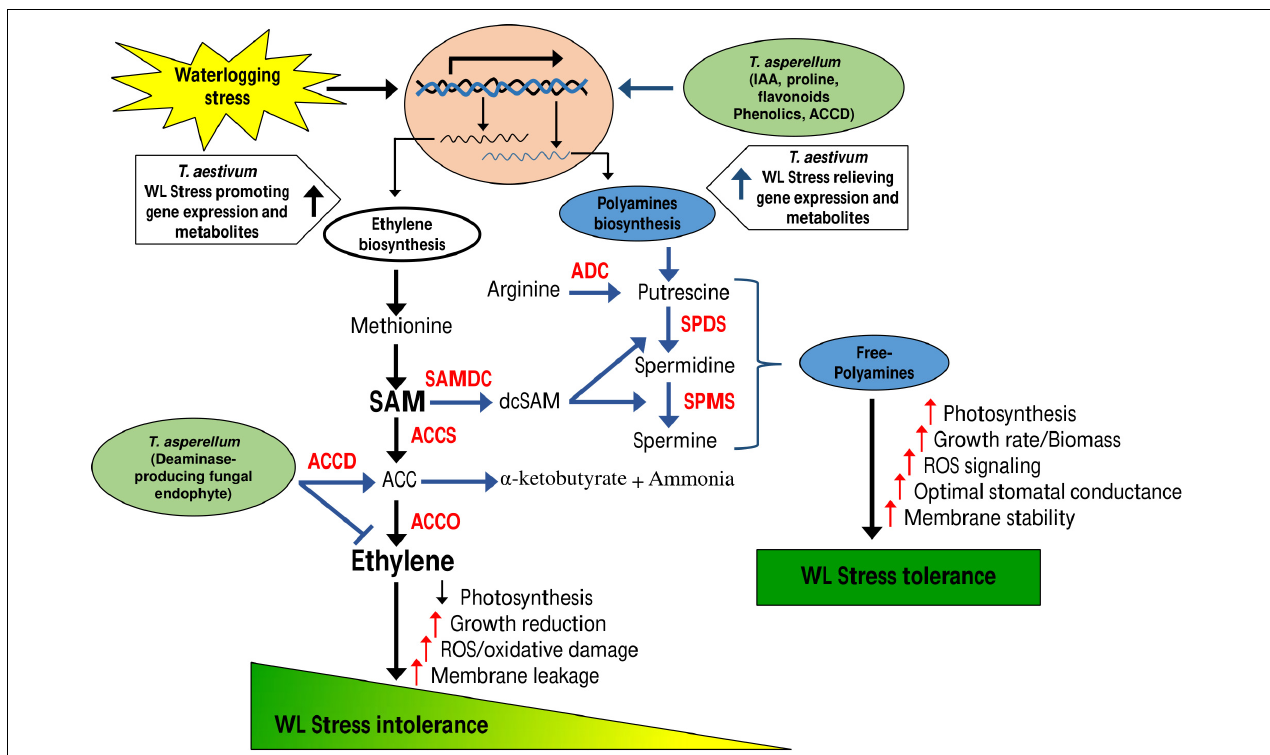
FIGURE 10 | Model of T. asperellum MAP1 action during waterlogging-induced